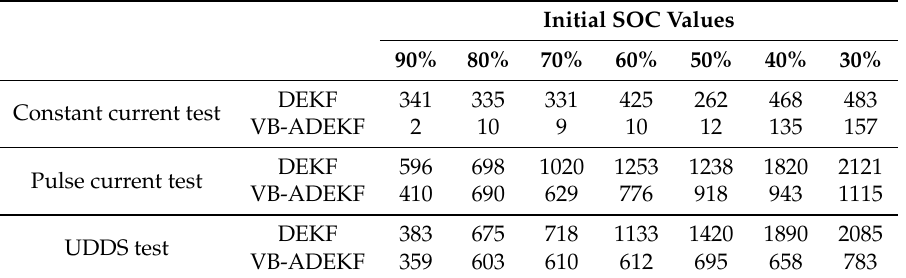
Table 3. Convergence time (s) of variational Bayesian approximation-based adaptive dual extended Kalman filter (VB-ADEKF) and dual extended Kalman filter (DEKF) with different initial SOC values.